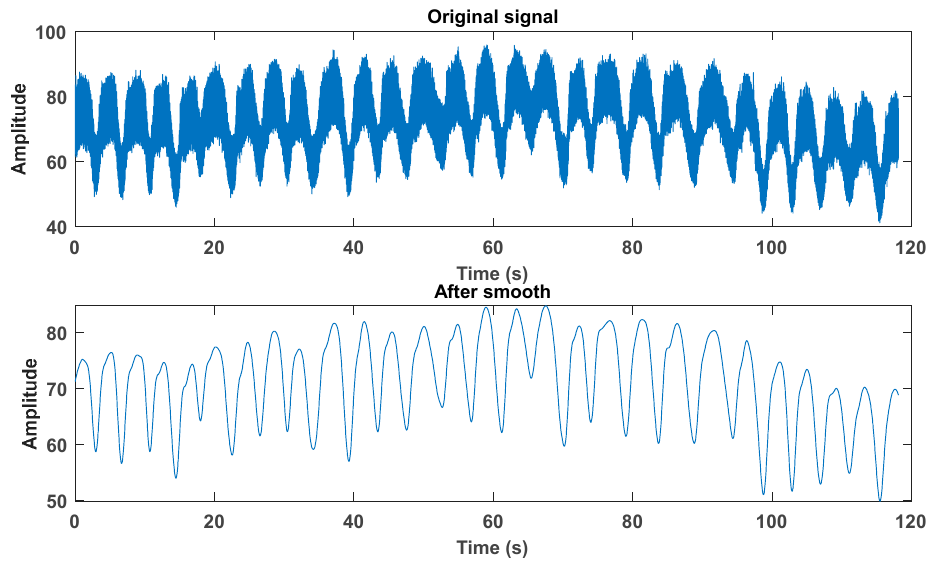
Figure 5. Subcarrier smoothing processing.